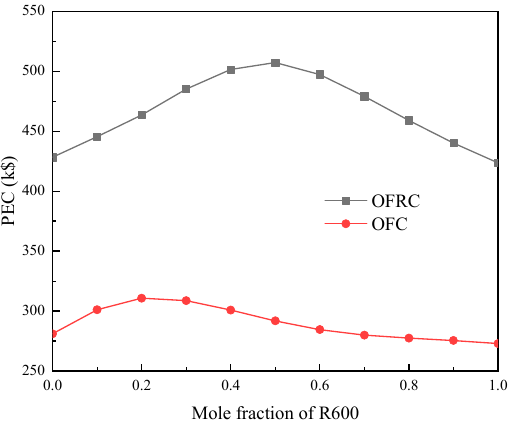
Figure 13. Variation of the total system cost with the R600 mole fraction.